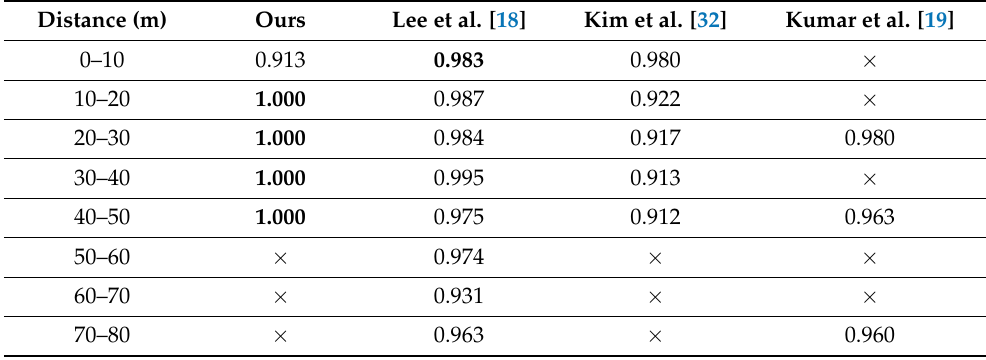
Table 4. Threshold accuracy results (in % δ < 1.25 ) of the proposed distance prediction framework’s on-road evaluation at various distance